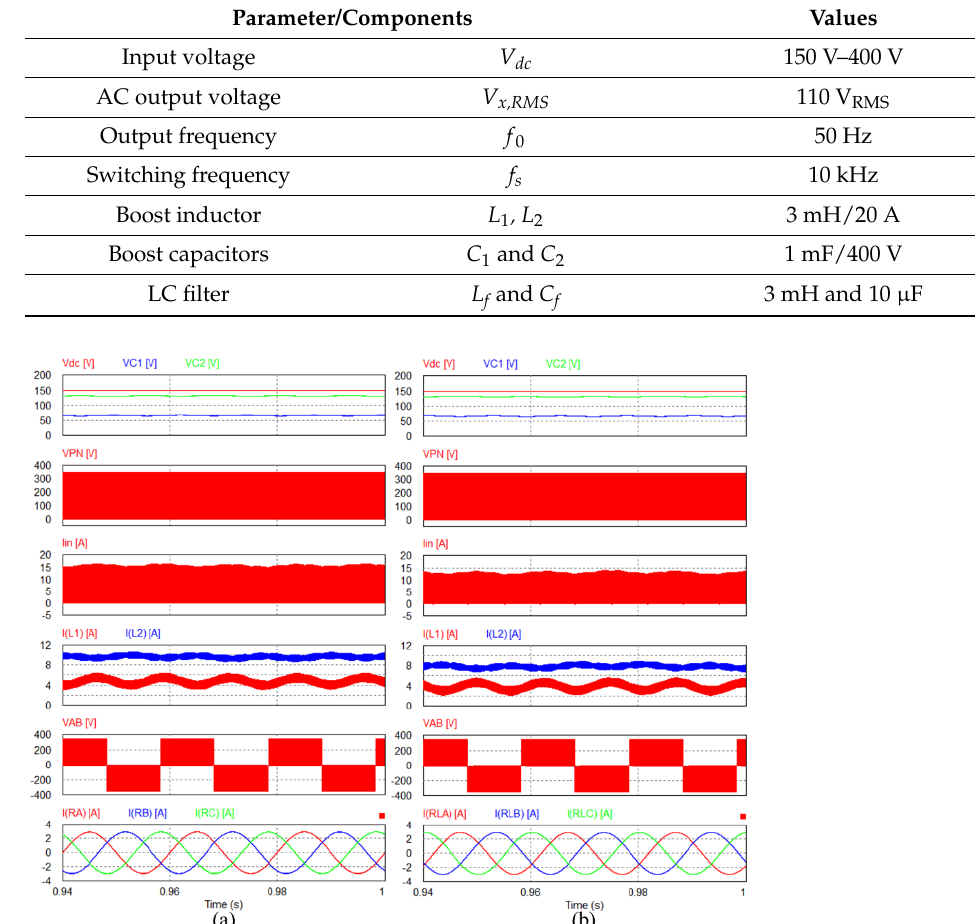
Table 4. Simulation and experimental parameters.